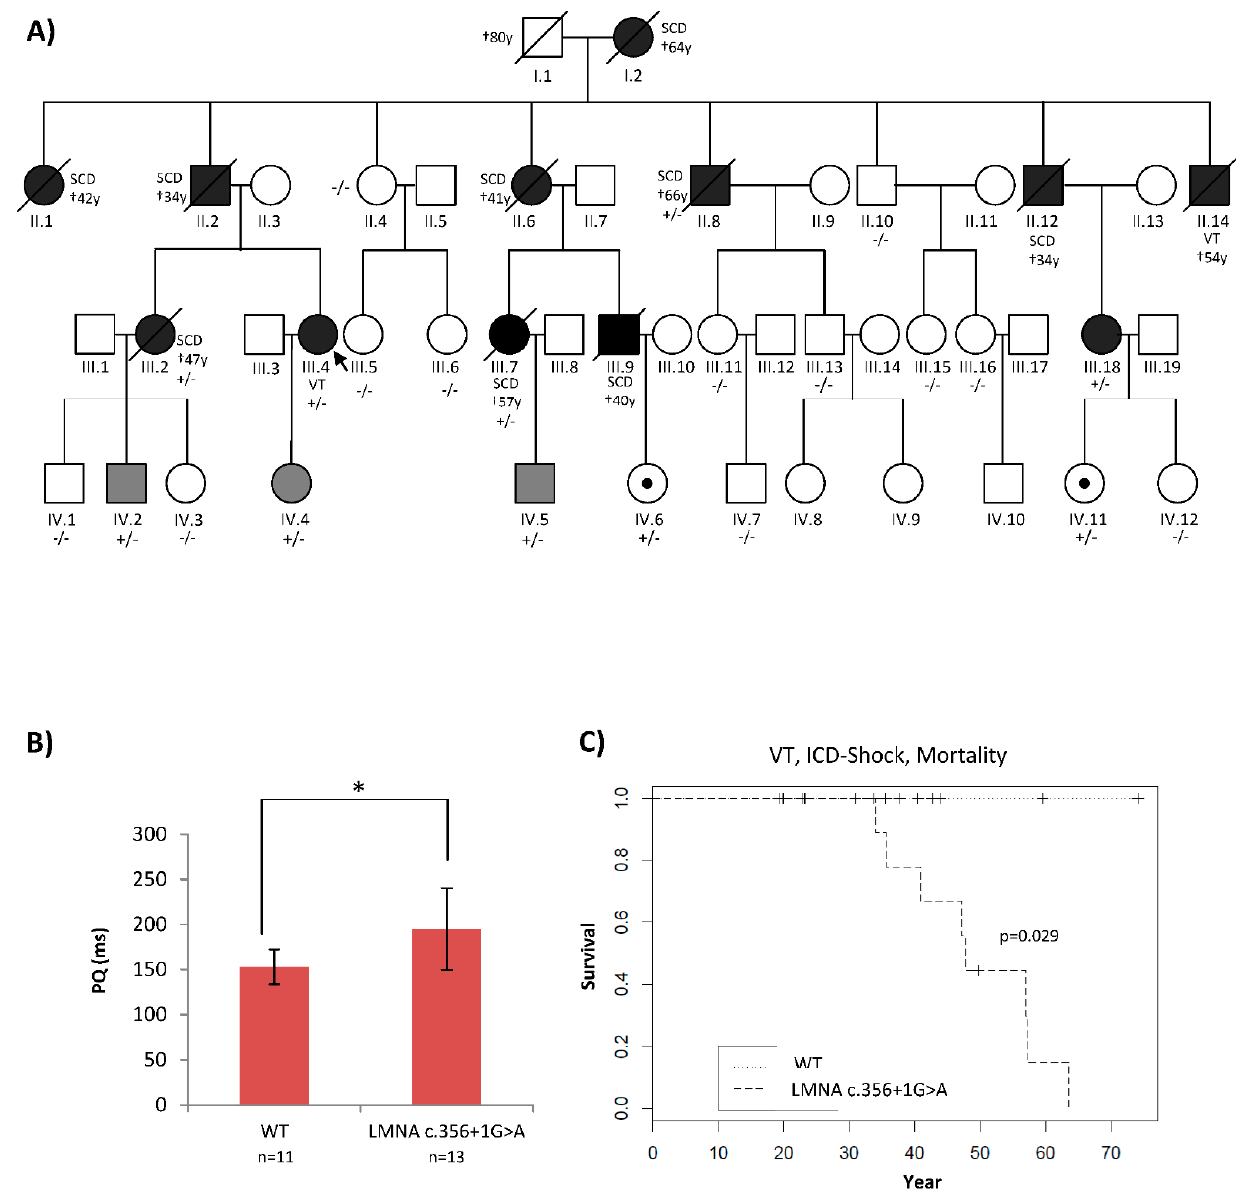
Figure 1. ( A ): Patient’s pedigree showing co-segregation of an LMNA splice site mutation, LMNA c.356+1G>A . The index patient was diagnosed with DCM and conduction disease of 40 years and underwent ICD implantation. At age 47, he received an adequate ICD therapy. +/ − is heterozygous, − / − is the homozygous wild type. Black: full phenotype, grey: mild phenotype, dot: genotype positive/phenotype negative. Symbol with a diagonal line: Deceased. Dagger indicates the age of death. ( B , C ): Patients who carried LMNA c.356+1G>A had significantly longer PQ intervals and higher rates of ventricular arrythmia and mortality. * p < 0.05.